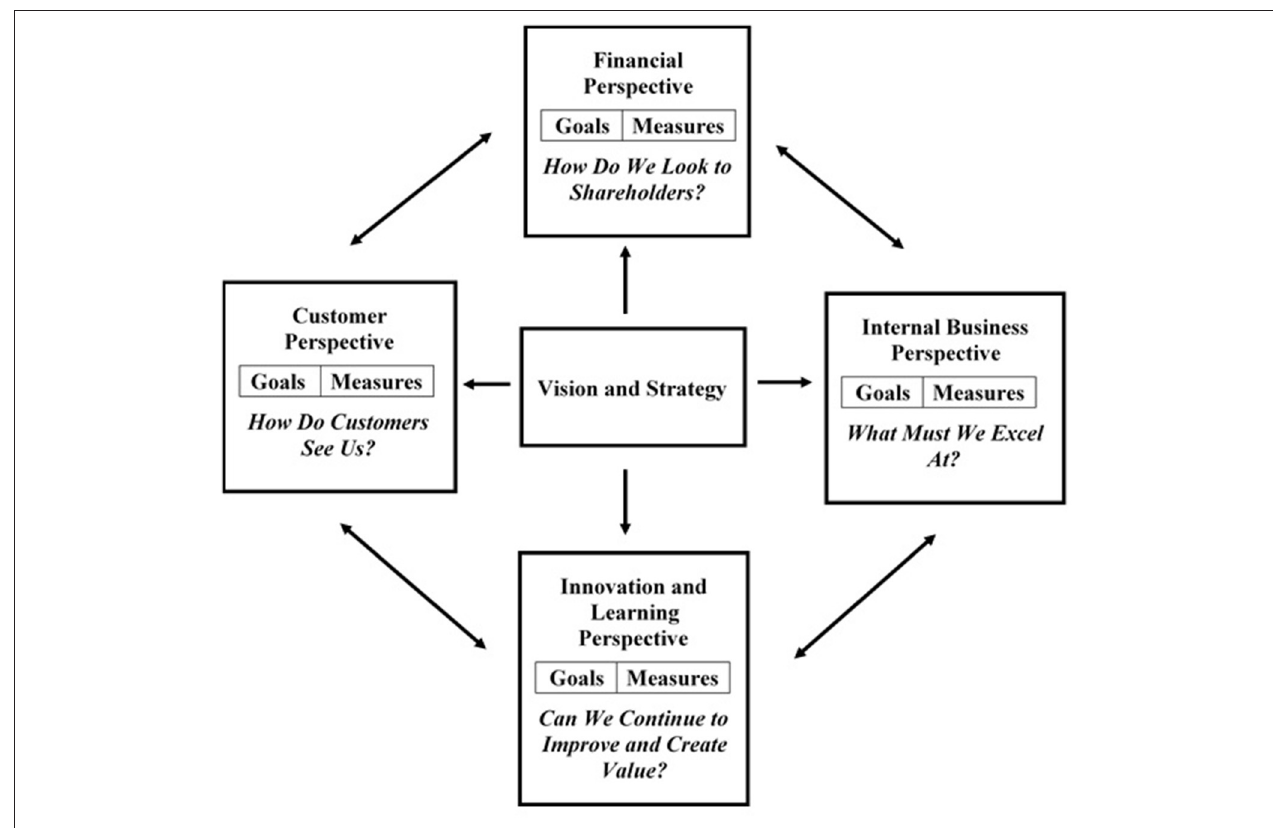
FIGURE 1 | The balanced scorecard links performance measures (Kaplan and Norton,